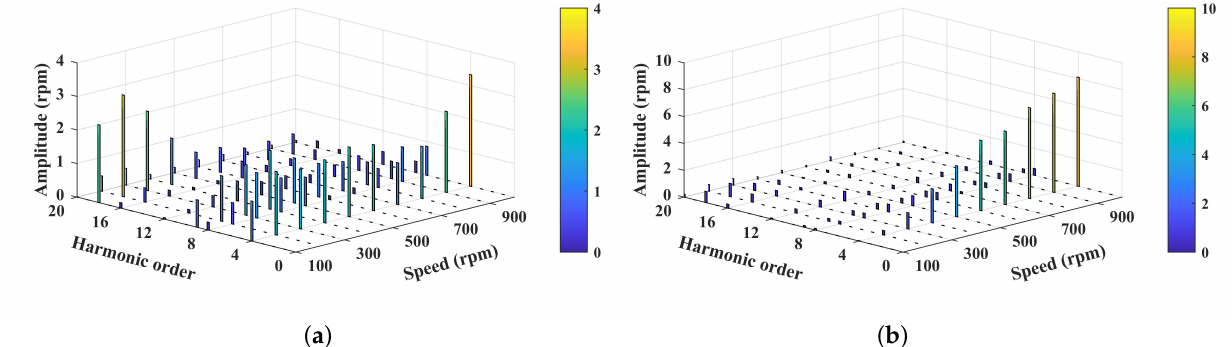
Figure 7. Spectrum analysis of the speed ripple: ( a ) in the conventional ESO-ADRC system and ( b ) in the NN-ESO-ADRC system with single